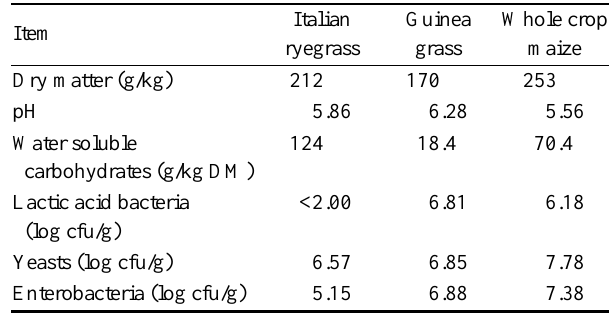
Table 1. Characteristics of pre-ensiled crops